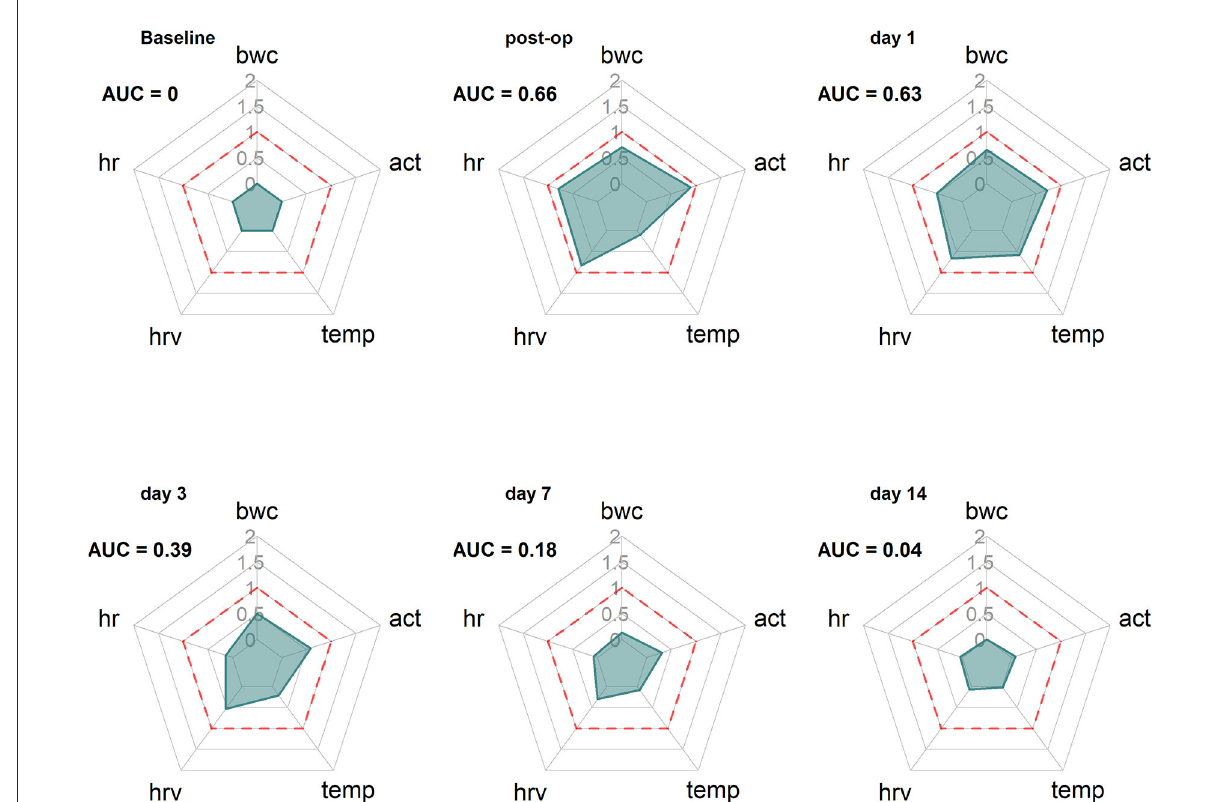
FIGURE7 Radar charts reveal the time-dependent changing contribution of the outcome measures bwc, act, temp, hrv, and hr to the RELSA. The RELSA weights (RW) from the TM-implantation subgroup ( n = 13) are averaged on six days (baseline, post-op day 0, day 1, day 3, day 7, and day 14) of the experiment. The dashed red line indicates the RELSA reference level of 1. Note, e.g., how the hrv stays elevated longer than the other outcome measures, showing the different and animal-model dependent qualities that single variables can assume in severity